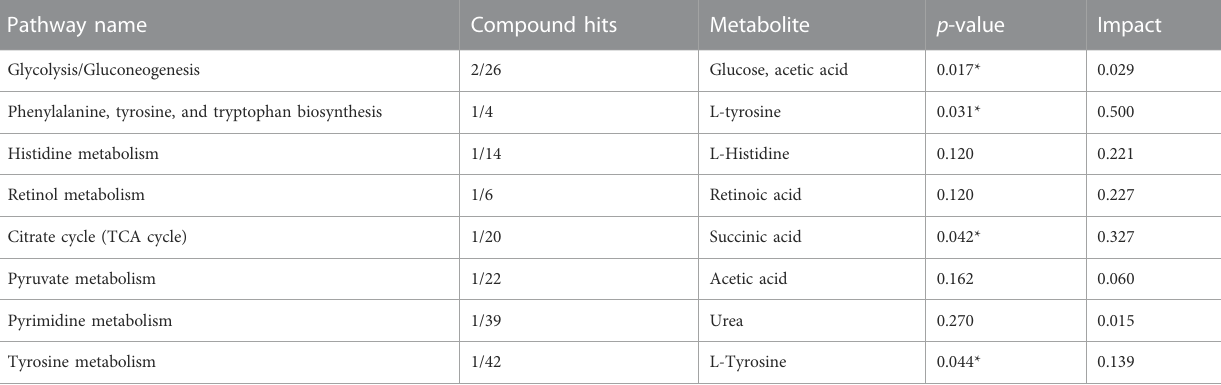
TABLE 2 Metabolic pathways most affected during Trichinella zimbabwensis infection in Sprague Dawley rats from the pathway-impact